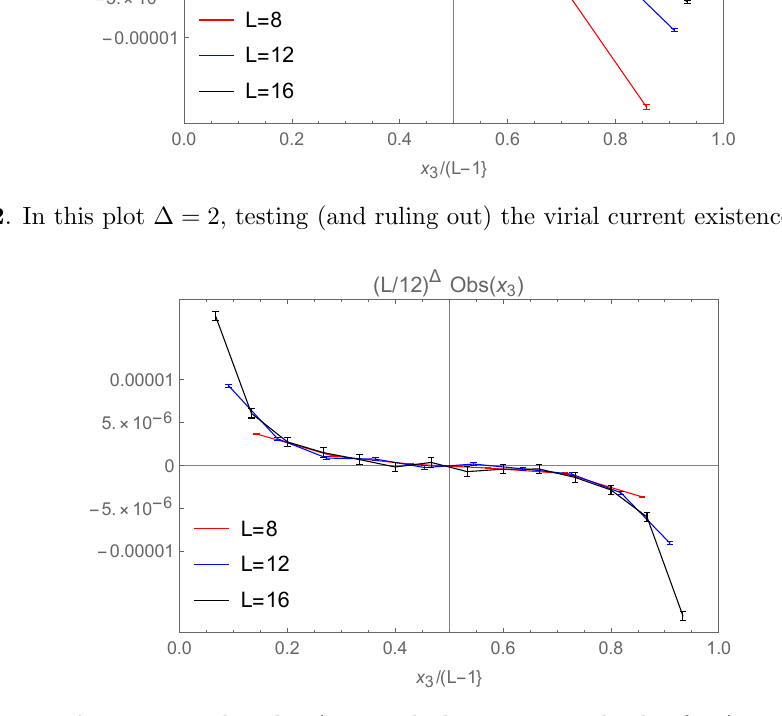
Figure 3 . In this plot (cid:1) = 6, which is our central value for (cid:1) V